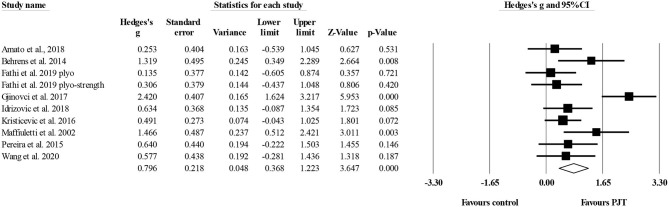
Forest plot of changes in countermovement jump performance in volleyball players participating in plyometric jump training (PJT) compared to controls. Values shown are effect sizes (Hedges's g) with 95% confidence intervals (CI). The size of the plotted squares reflects the statistical weight of the study.